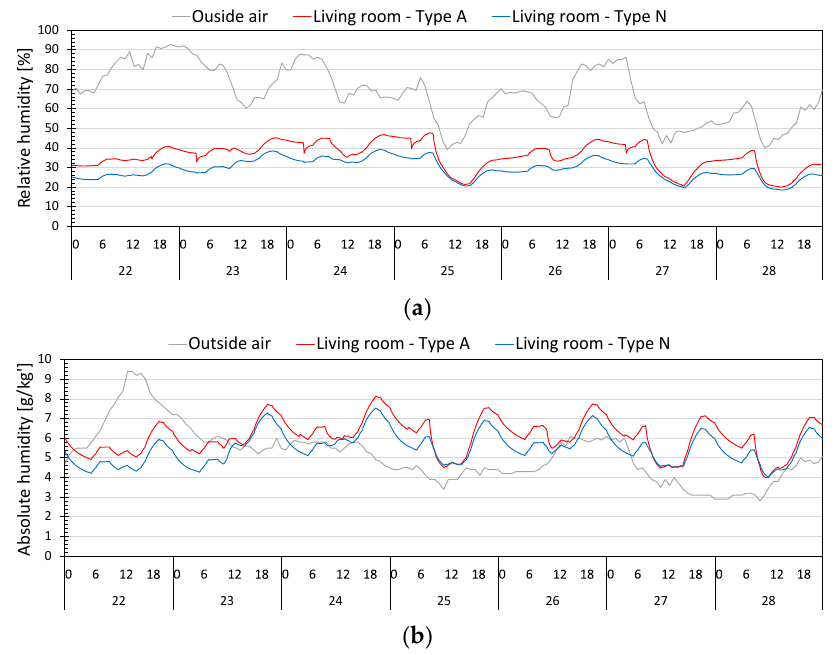
Figure 11. Over-drying prevention effect: ( a ) relative humidity; ( b ) absolute humidity (February).